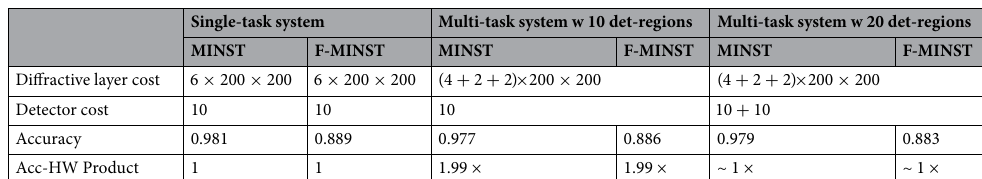
2 NN architectures. For the